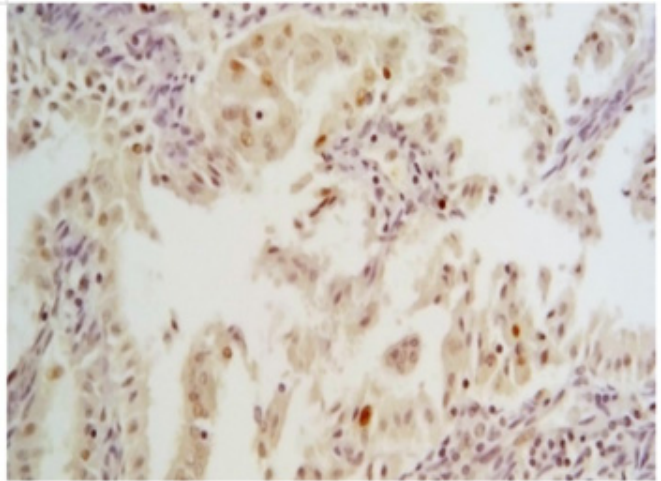
Figure 3. Wild ‐ type pattern of p53 by IHC (magnification 200×). It is characterized by a focal ex ‐ pression with variable but bland intensity in nuclei of neoplastic cells.